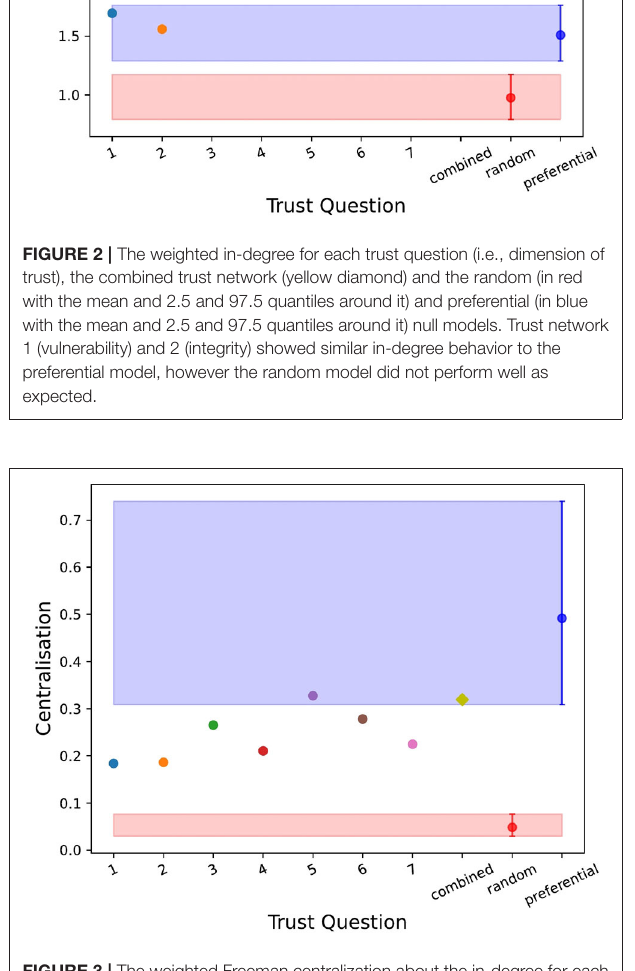
FIGURE 3 | The weighted Freeman centralization about the in-degree for each trust question (i.e., dimension of trust), the combined trust network (yellow diamond) and the random (in red with the mean and 2.5 and 97.5 quantiles around it) and preferential (in blue with the mean and 2.5 and 97.5 quantiles around it) null models. Trust questions 5 and the combined network showed similar behavior to the preferential model, however, the random model yielded low values of centralization.